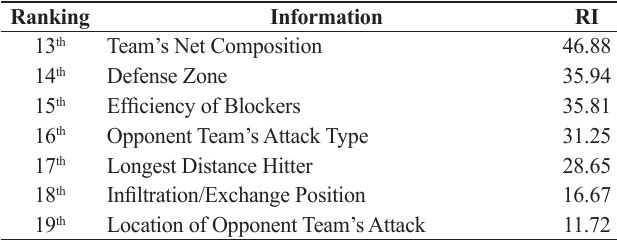
Table 5: Classification of information contained in the Counter-Attack Processes based on the response rate